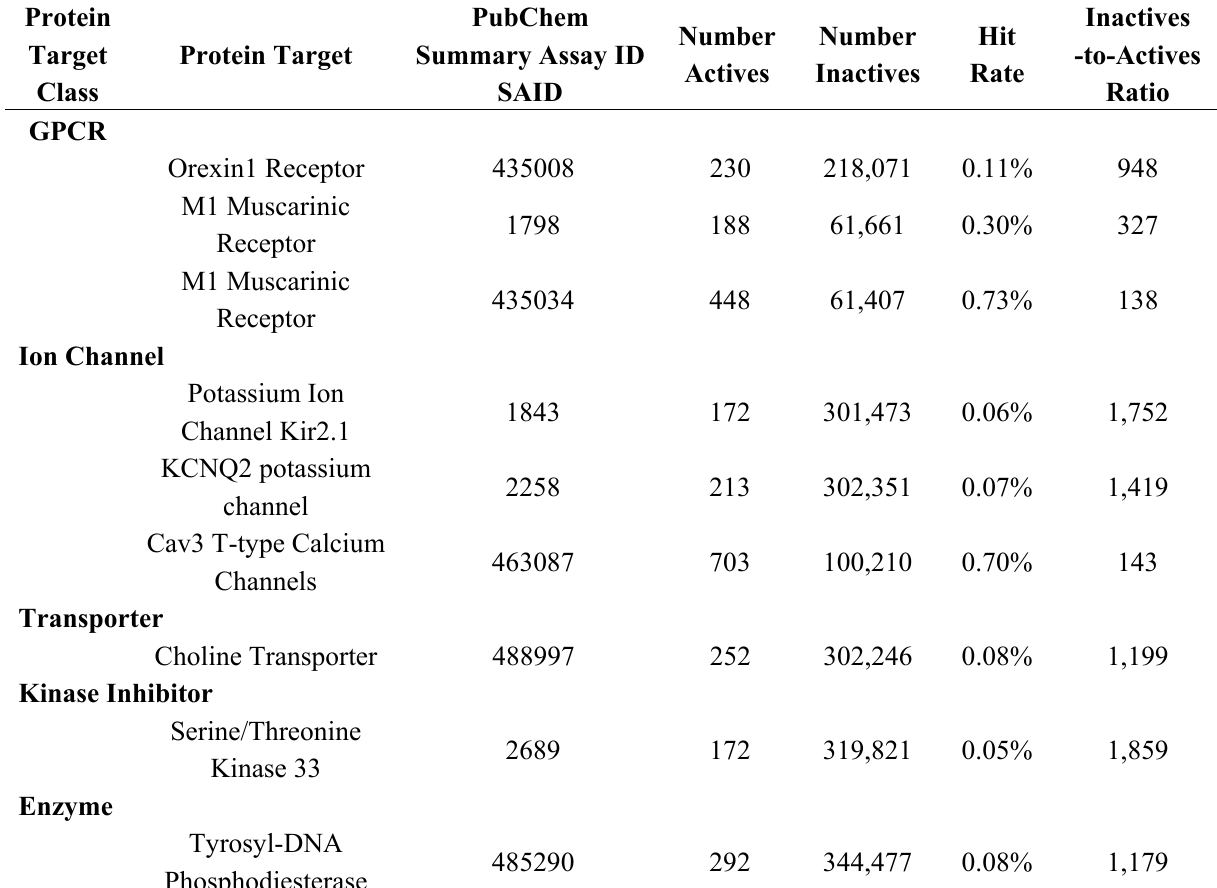
Table 1. Overview of PubChem biological assays and data set